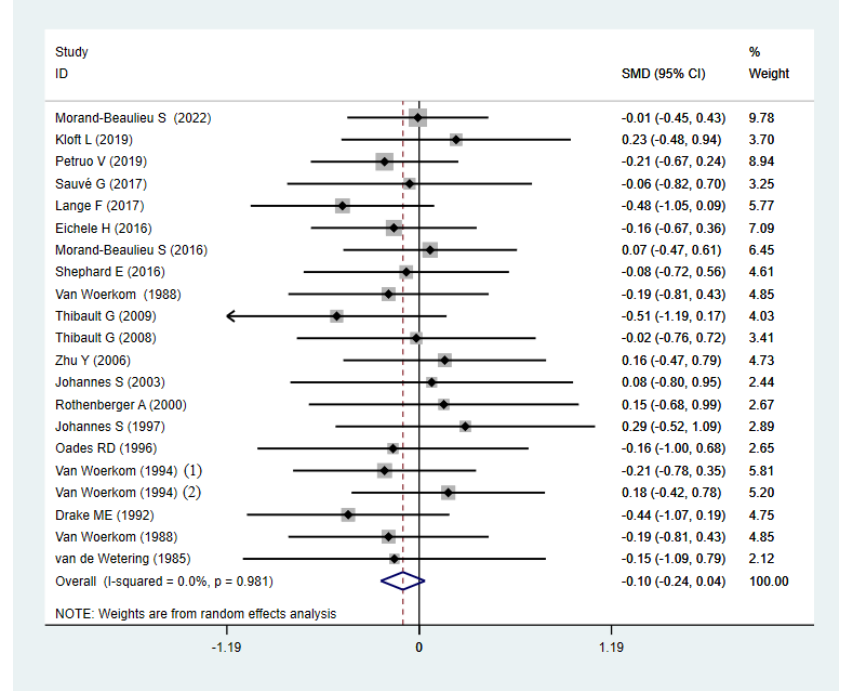
Figure 5. Meta-analysis on the forest map of P3b latency of TD patients and HCs. SMD: Standard Mean Difference; CI: confidence interval.